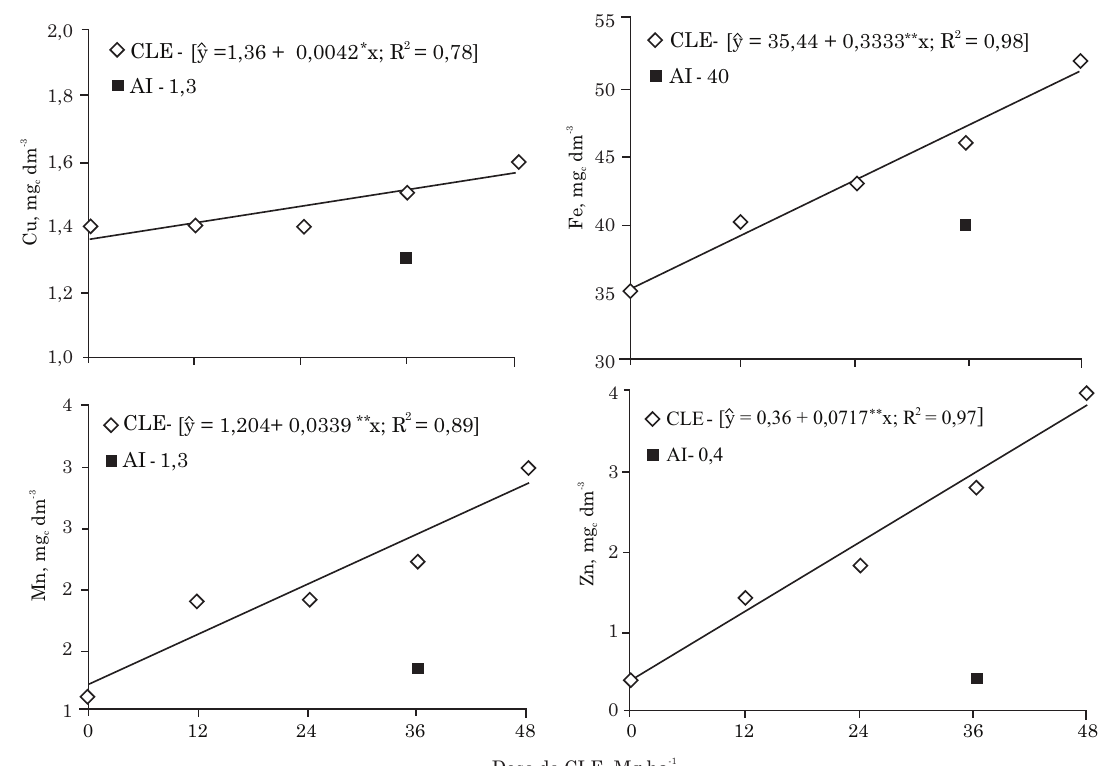
Figura 5. Teores de micronutrientes no solo, na camada de 0-0,2 m, após o corte dos tapetes de grama Imperial, em função de doses de composto de lodo de esgoto (CLE) e adubação inorgânica (AI), aos 13 meses após a aplicação do